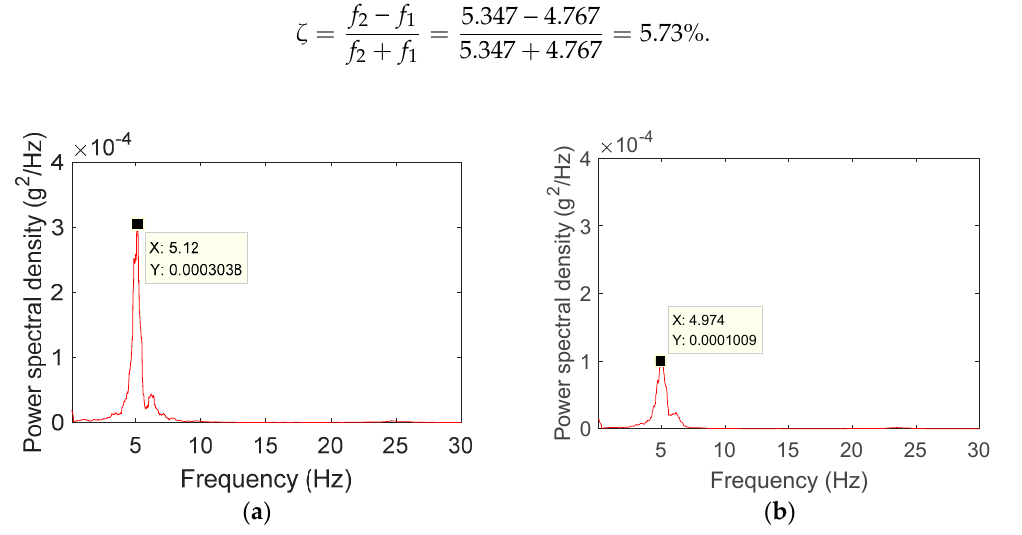
Figure 11. Power spectral density function of acceleration sensor J10. ( a ) Without water and ( b ) with water. Table 8. Damping ratio of the first-order mode of the platform.